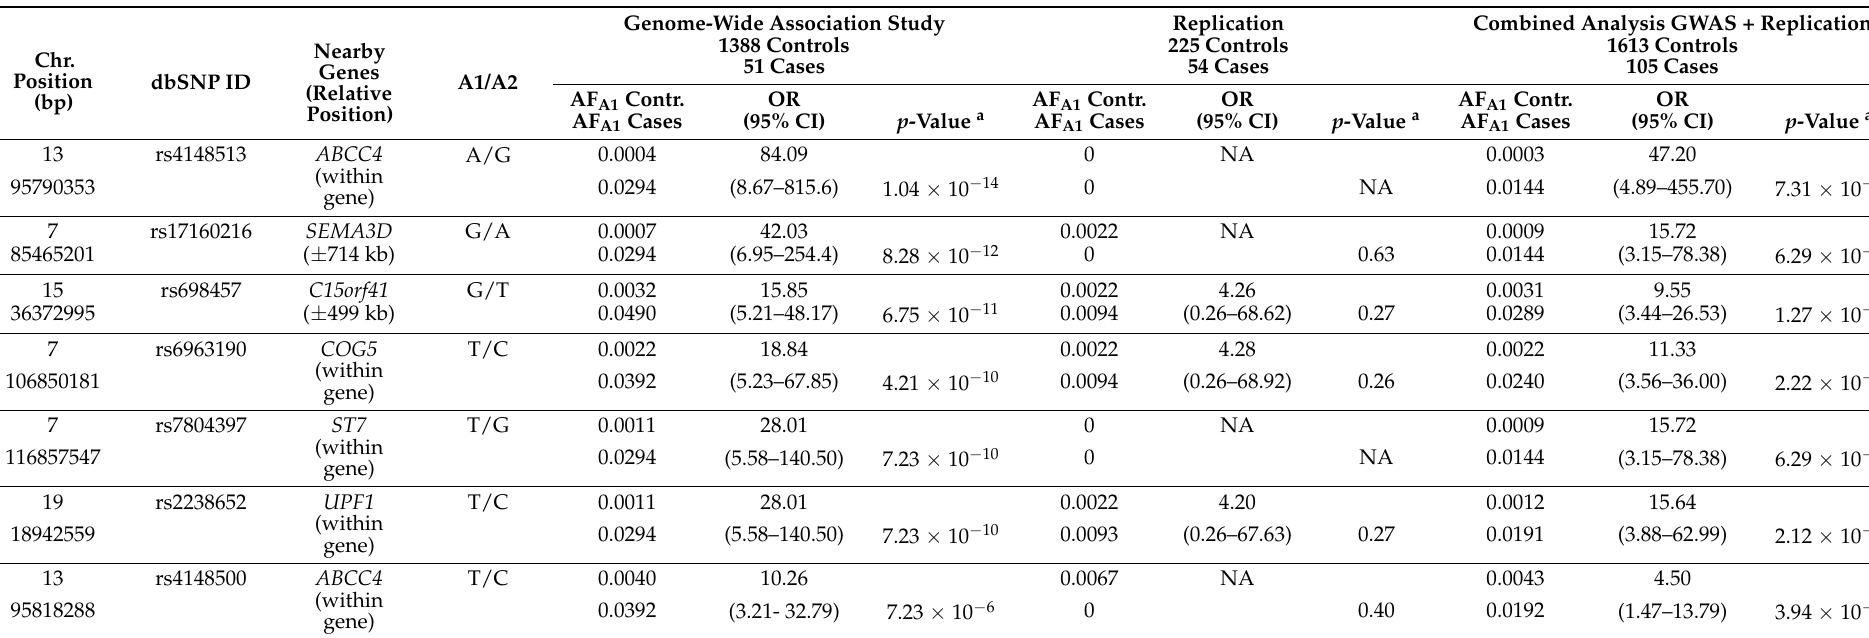
Table 2. Top SNVs associated with AP identified by genome-wide association analysis and replicated by Sanger sequencing: approach 1.